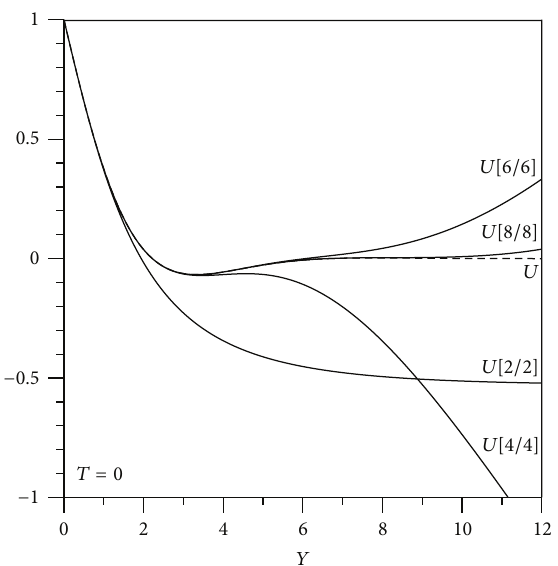
Figure2:ComparisonofPad´e [𝑛/𝑛] solutions(solidlines)andexact solution (dash line) for Stokes’ second problem at 𝑇 = 𝜋/2